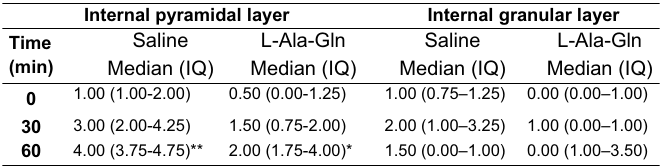
TABLE 4 - Quantification of red neurons in the internal pyramidal layer and the internal granular layer of the cerebral cortex for Group S (saline solution) and Group G (L-alanyl-L-glutamine) before (T ) and 0 after 30 minutes (T ) and 60 minutes (T ) of reperfusion. 30 60